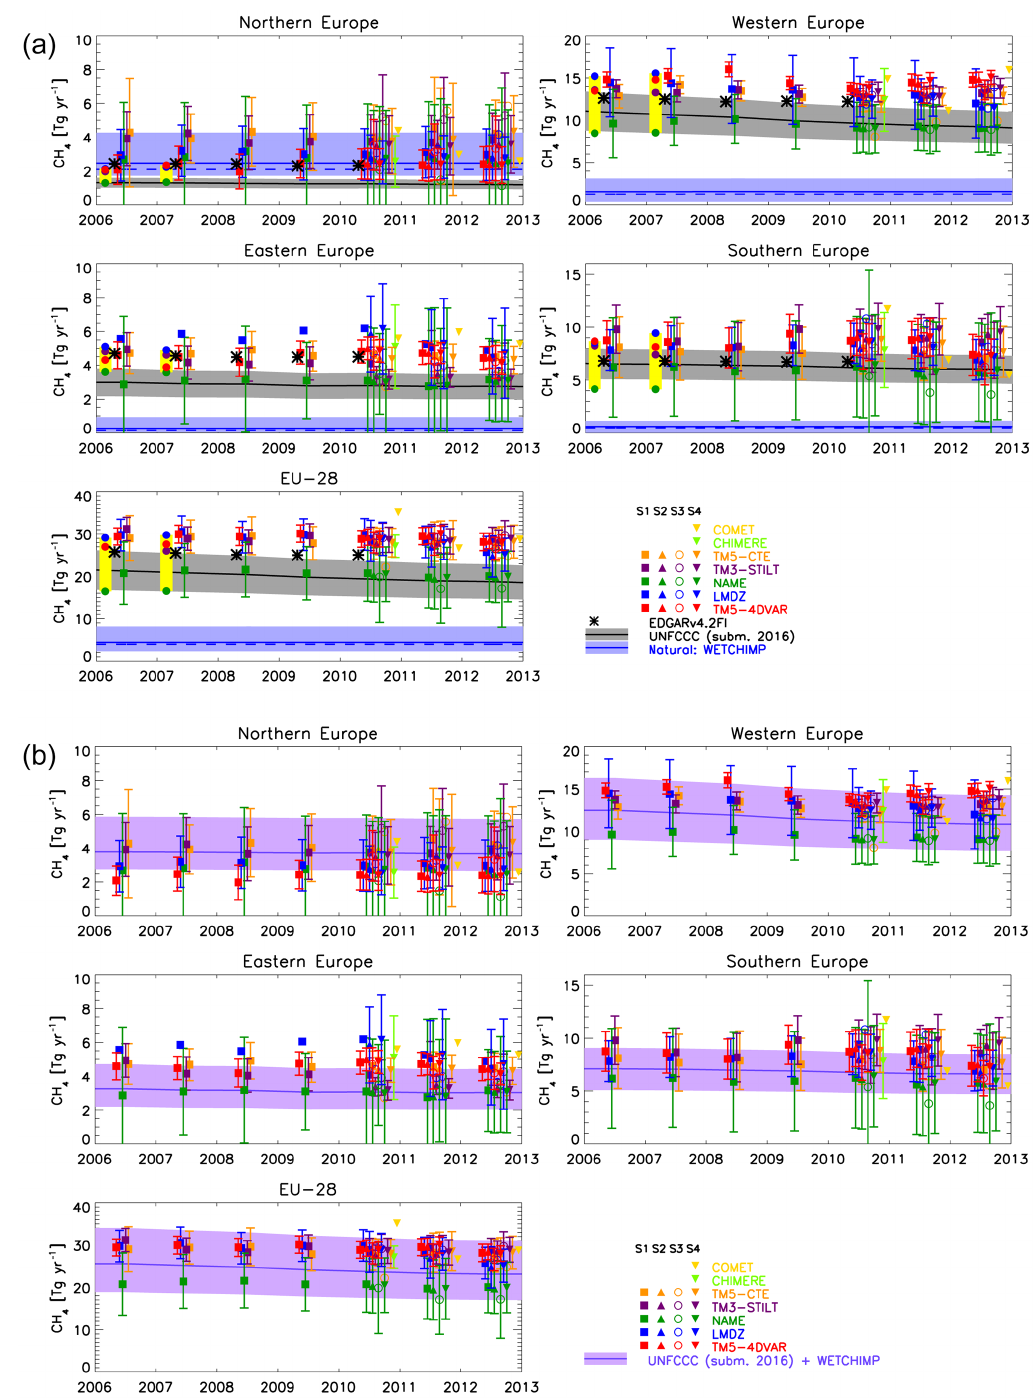
Figure 3. (a) Annual total CH 4 emissions derived from inversions for northern, western, eastern, and southern Europe, and for EU-28 (coloured symbols; bars show estimated 2 σ uncertainties). For comparison, anthropogenic CH 4 emissions reported to UNFCCC (black line; grey range: 2 σ uncertainty estimate based on National Inventory Reports), and from EDGARv4.2FT-InGOS (black stars) are shown. Furthermore, the blue lines show wetland CH 4 emissions from the WETCHIMP ensemble of seven models (mean, blue solid line; median, blue dashed line; minimum–maximum range, light-blue range). The previous estimates of total CH 4 emissions from Bergamaschi et al. (2015) for 2006 and 2007 are shown within the yellow rectangles. (b) Comparison of annual total CH 4 emissions derived from inversions with the sum of anthropogenic CH 4 emissions reported to UNFCCC and wetland CH 4 emissions from the WETCHIMP ensemble (violet line; the light-violet range is the combined uncertainty range based on the 2 σ uncertainty of UNFCCC inventories and the minimum–maximum range of the WETCHIMP